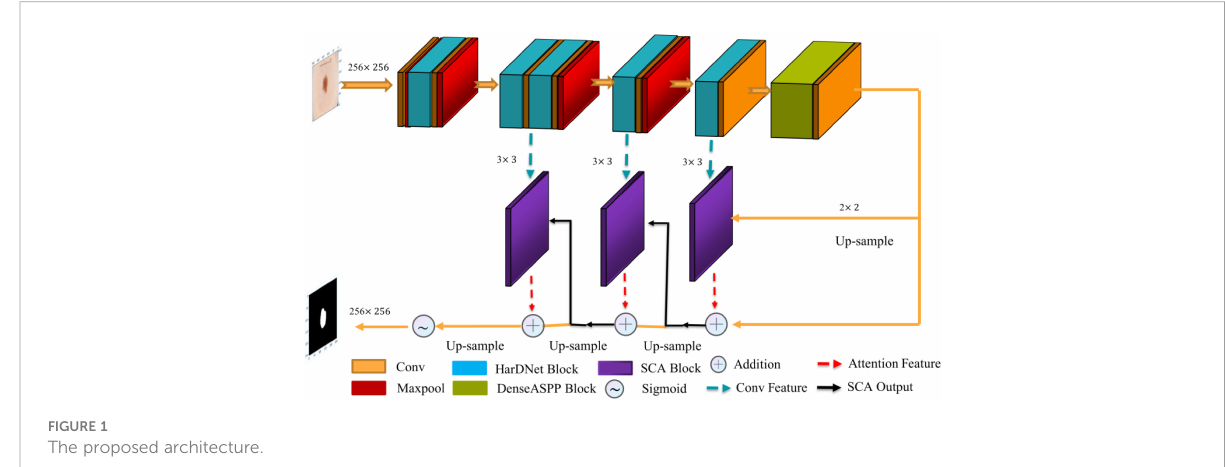
FIGURE 1 The proposed